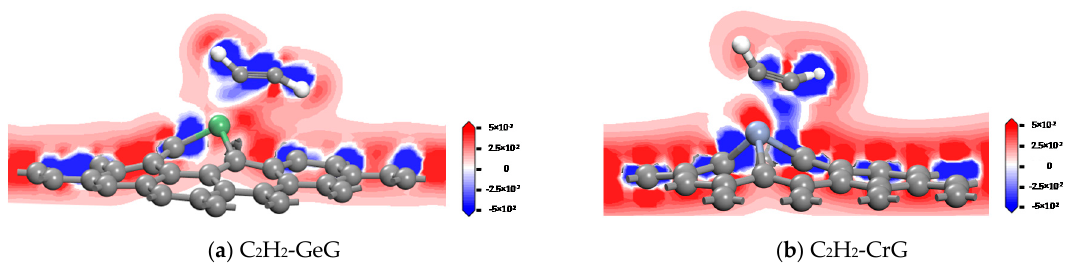
Figure 12. The charge density difference of the C 2 H 2 molecule on GeG (a) and CrG (b)